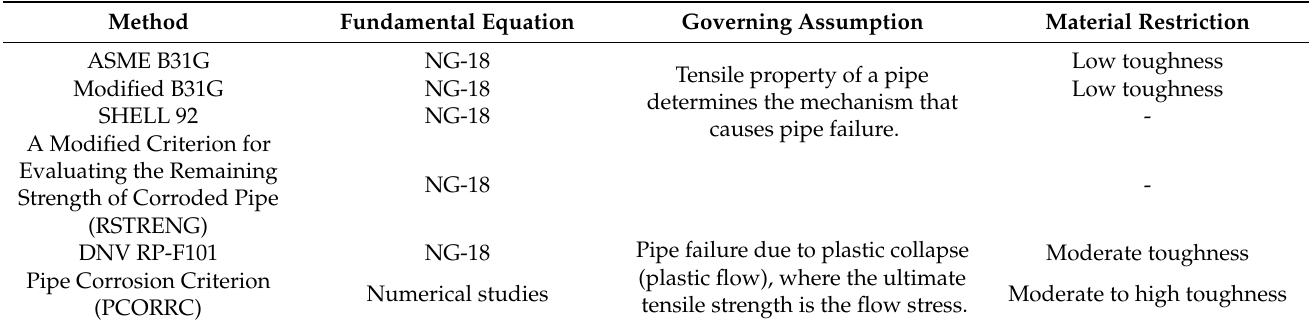
Table 1. Comparison of pipe failure pressure assessment